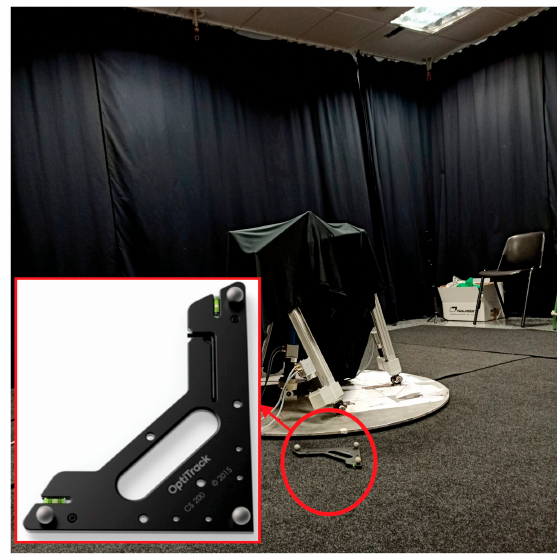
Figure 7. Calibration